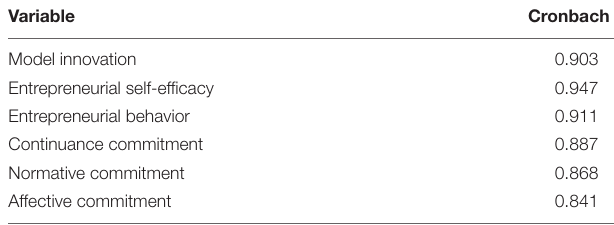
TABLE 4 | Test results of questionnaire reliability.